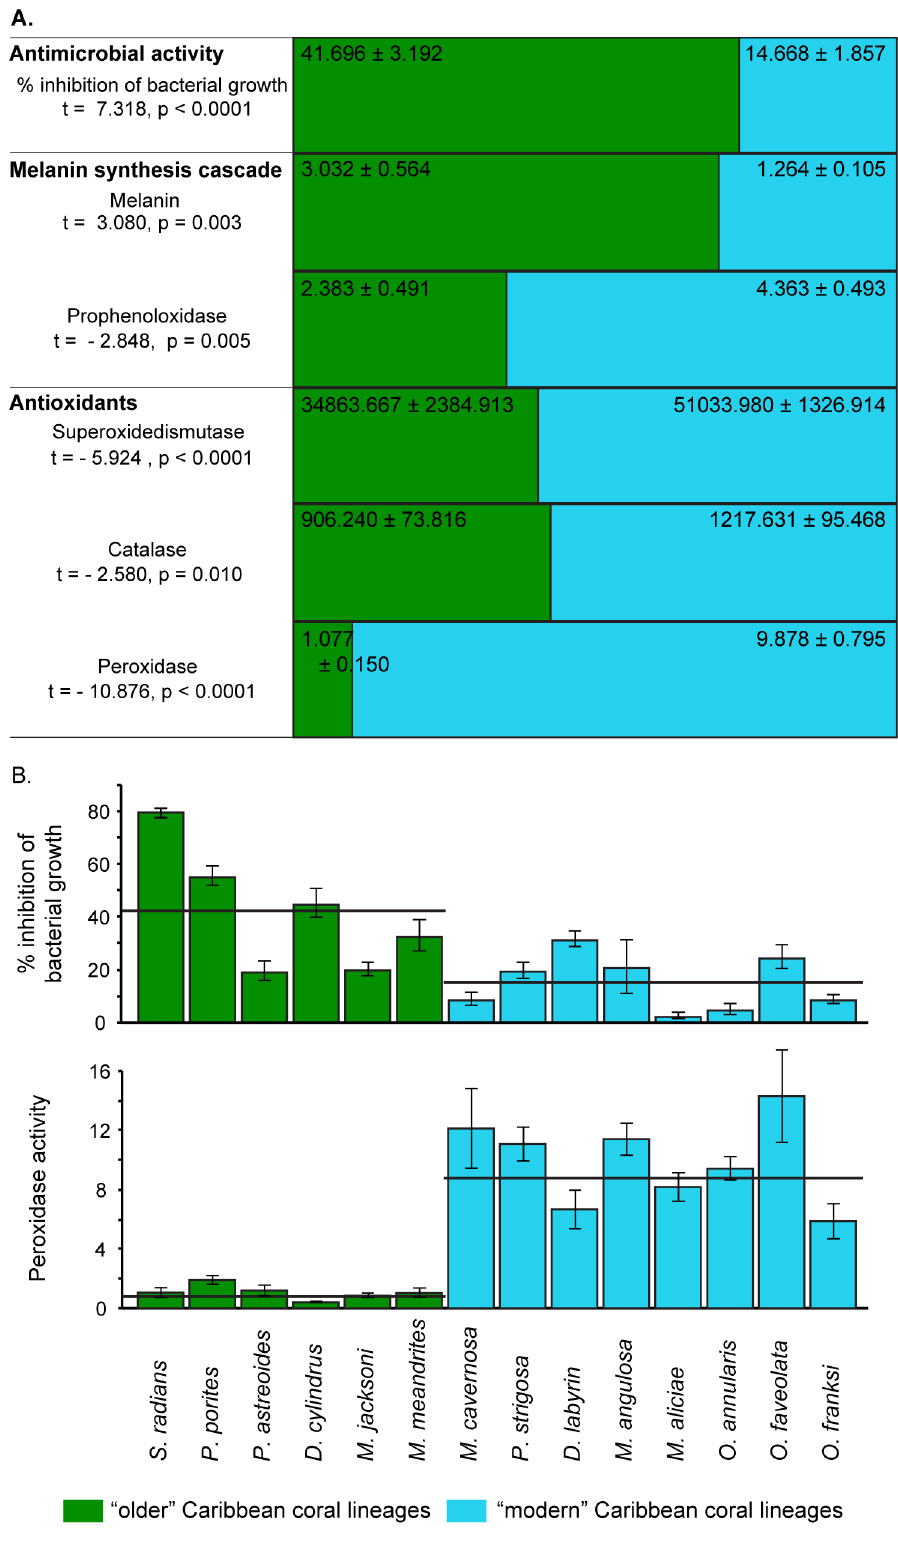
Figure 4. Proportion of the mean ( ± standard error) values of constitutive levels of six immune traits (percent inhibition of bacterial growth, melanin concentration, prophenoloxidase, superoxide dismutase, peroxidase and catalase activity) for older and modern Caribbean coral lineages (A). Pairwise comparisons for each trait using t-tests assuming unequal variances revealed significant differences between older and modern lineages for all traits. Older lineages showed higher mean values of melanin and percent inhibition of bacterial growth and lower values in the other traits compared to the modern lineages. Percent inhibition of bacterial growth and peroxidase activity (mean 6